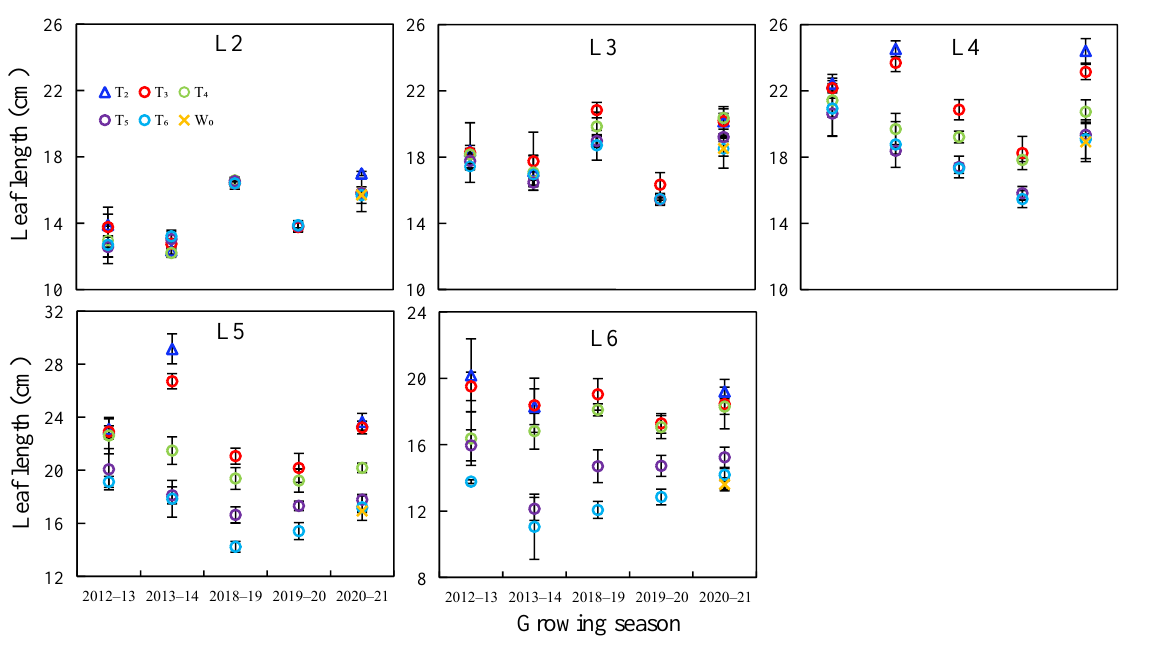
Figure 2. Leaf length for different treatments in each wheat growing season. L2 – L6 represent the second leaf to the sixth leaf in springtime, and the sixth leaf is the last. T 2 , T 3 , T 4 , T 5 , and T 6 refer to the first irrigation and nitrogen topdressing at the appearance of the second, third, fourth, fifth, and sixth spring leaf, respectively. T 2 was not set in the growing seasons from 2018 to 2019 and 2019 to 2020, and W 0 was set only in the growing season from 2020 to 2021. Table 2. Analysis of variance (ANOVA) for the effects of different irrigation, N topdressing treatments, and year on the length of each organ. Organs Treatments